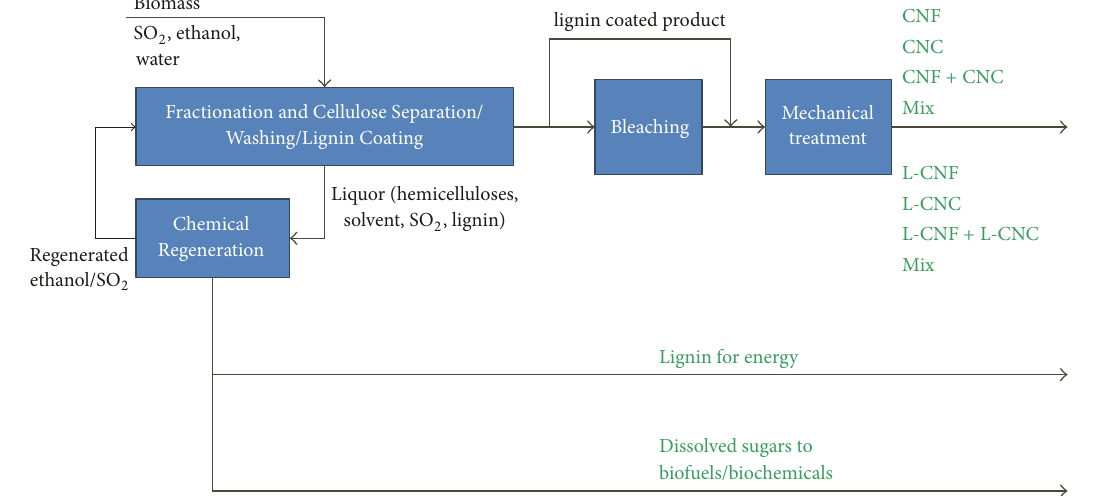
Figure 8: A simplified process flow diagram of the AVAP NCs process [84].